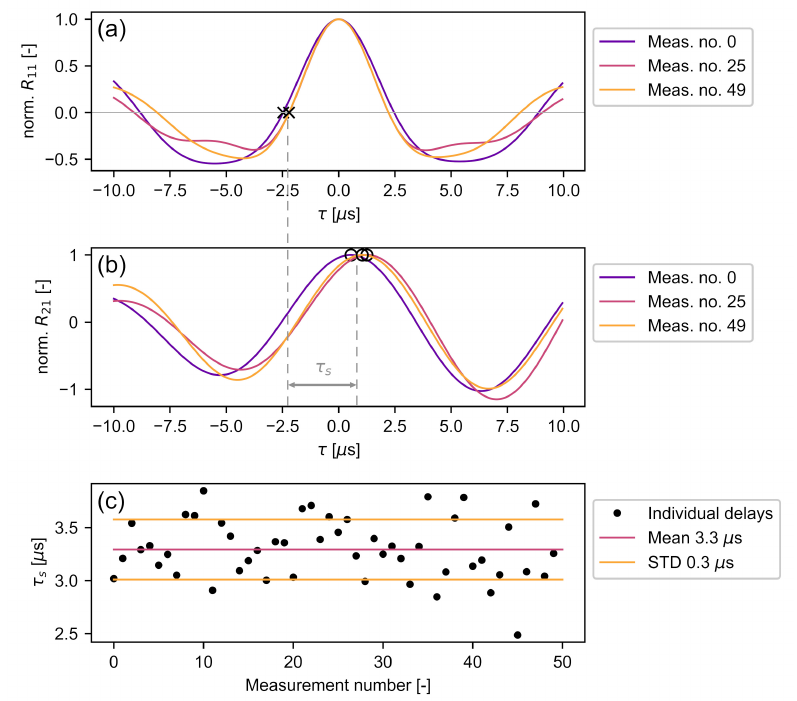
Figure 7. Calculation of hardware delay τ h : ( a ) shows three autocorrelation outputs of the RV signal, where × denotes a − π /2 phase shift; ( b ) shows the corresponding cross-correlation outputs of the RV and accelerometer data, where ◦ denotes the correlation maximum; ( c ) shows the calculated τ h for 50